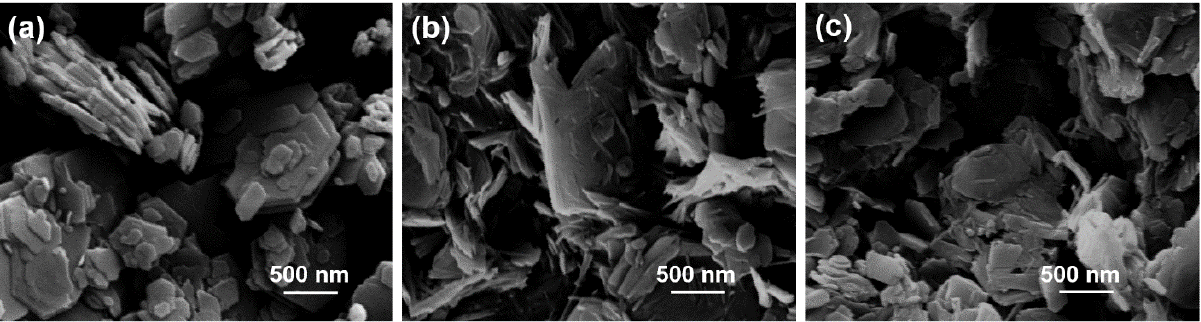
Figure 5. FE-SEM images of ( a ) MeO-Kaol, ( b ) C18TAC/MeO-Kaol_Wash, and ( c ) C18TAB/MeO- Kaol_Wash.